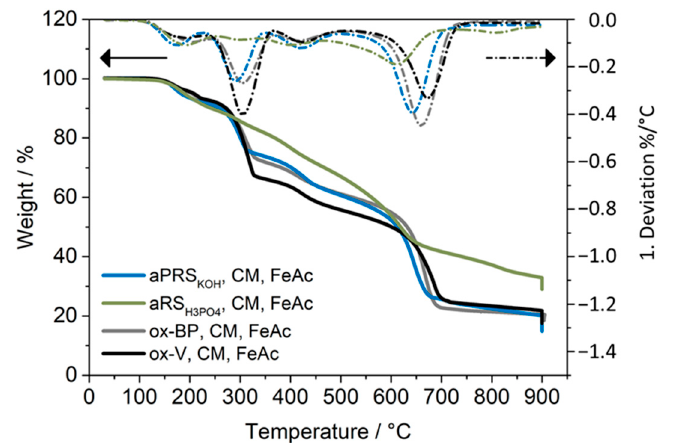
Figure 4. Thermogravimetric analysis with mass loss and first deviation during synthesis of Fe-N-aPRS KOH , Fe-N-aRS H3PO4 . Fe-N-ox-BP and Fe-N-ox-V, using cyanamide (CM) and iron(II) acetate (FeAc).